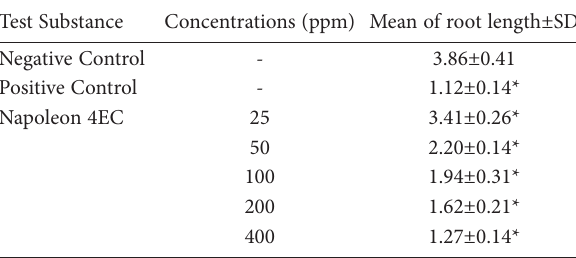
Table 2. Allium root growth inhibition test. Test